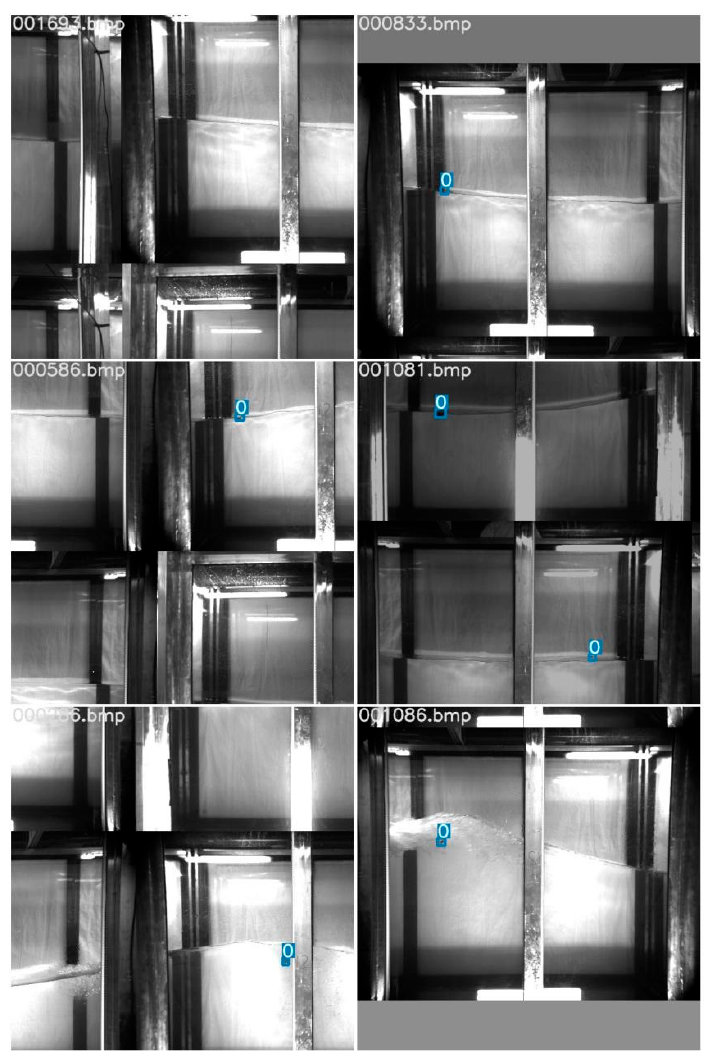
Figure 2. The performance of image enhancement during